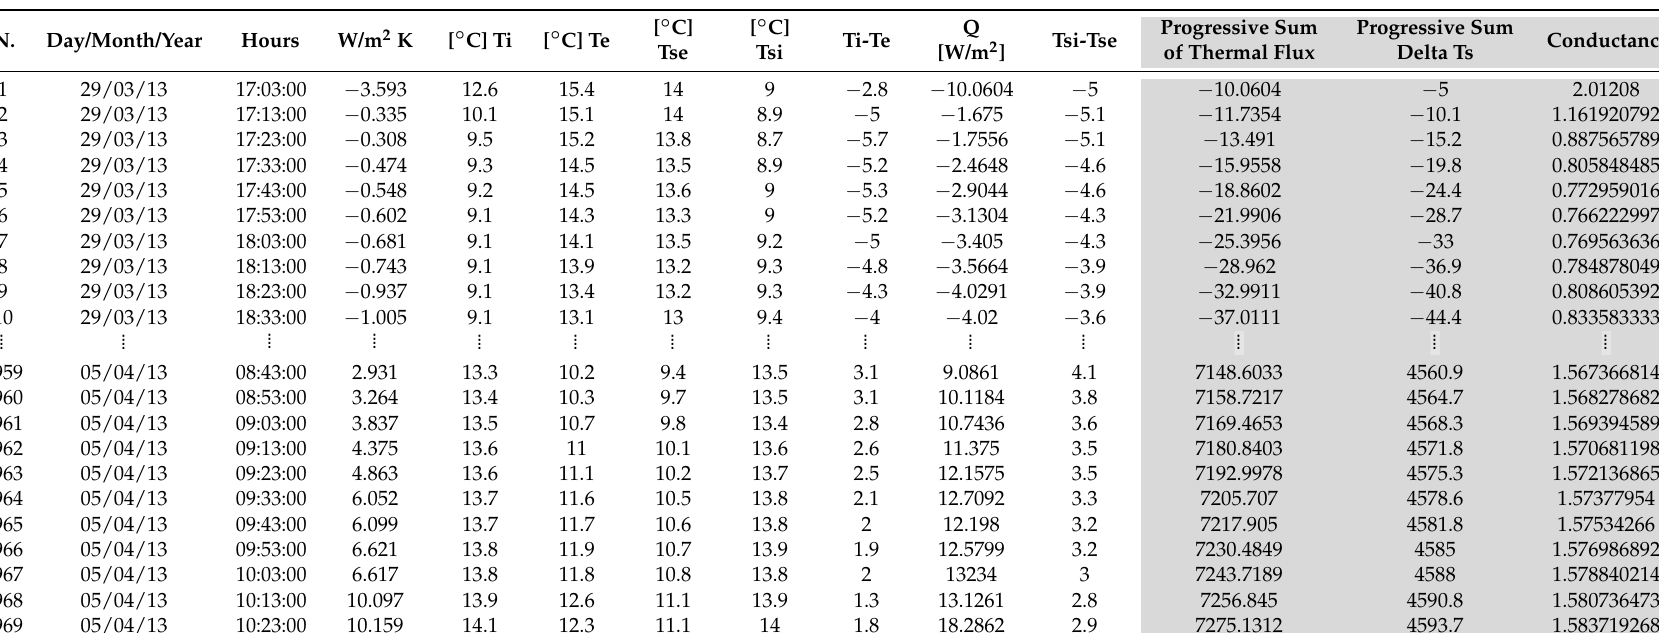
Table 4. On the left side, the data detected by the thermal flux meter. Tabular output. In particular, the data in the table concern the first and the last 10 measurements, so as to highlight the variation of the parameters involved in the measurement. As mentioned, during the day, it was not possible to have a suitable difference of Table 2. On the left side, the data detected by the thermal flux meter Tabular output. In particular, in the table there are data concerning the first and the last 10 Table 2. On the left side, the data detected by the thermal flux meter Tabular output. In particular, in the table there are data concerning the first and the last 10 Table 2. On the left side, the data detected by the thermal flux meter Tabular output. In particular, in the table there are data concerning the first and the last 10 Table 2. On the left side, the data detected by the thermal flux meter Tabular output. In particular, in the table there are data concerning the first and the last 10 Table 2. On the left side, the data detected by the thermal flux meter Tabular output. In particular, in the table there are data concerning the first and the last 10 Table 2. On the left side, the data detected by the thermal flux meter Tabular output. In particular, in the table there are data concerning the first and the last 10 Table 2. On the left side, the data detected by the thermal flux meter Tabular output. In particular, in the table there are data concerning the first and the last 10 Table 2. On the left side, the data detected by the thermal flux meter Tabular output. In particular, in the table there are data concerning the first and the last 10 Table 2. On the left side, the data detected by the thermal flux meter Tabular output. In particular, in the table there are data concerning the first and the last 10 Table 2. On the left side, the data detected by the thermal flux meter Tabular output. In particular, in the table there are data concerning the first and the last 10 Table 2. On the left side, the data detected by the thermal flux meter Tabular output. In particular, in the table there are data concerning the first and the last 10 Table 2. On the left side, the data detected by the thermal flux meter Tabular output. In particular, in the table there are data concerning the first and the last 10 Table 2. On the left side, the data detected by the thermal flux meter Tabular output. In particular, in the table there are data concerning the first and the last 10 Table 2. On the left side, the data detected by the thermal flux meter Tabular output. In particular, in the table there are data concerning the first and the last 10 temperature, so the measurements were not taken into account. On the right side, against the grey background, the calculation of the variables referred to in the measurements, so as to highlight the variation of the parameters involved in the measurement. On the right side, against the grey background, the calculation of the measurements, so as to highlight the variation of the parameters involved in the measurement. On the right side, against the grey background, the calculation of the measurements, so as to highlight the variation of the parameters involved in the measurement. On the right side, against the grey background, the calculation of the measurements, so as to highlight the variation of the parameters involved in the measurement. On the right side, against the grey background, the calculation of the measurements, so as to highlight the variation of the parameters involved in the measurement. On the right side, against the grey background, the calculation of the measurements, so as to highlight the variation of the parameters involved in the measurement. On the right side, against the grey background, the calculation of the measurements, so as to highlight the variation of the parameters involved in the measurement. On the right side, against the grey background, the calculation of the measurements, so as to highlight the variation of the parameters involved in the measurement. On the right side, against the grey background, the calculation of the measurements, so as to highlight the variation of the parameters involved in the measurement. On the right side, against the grey background, the calculation of the measurements, so as to highlight the variation of the parameters involved in the measurement. On the right side, against the grey background, the calculation of the measurements, so as to highlight the variation of the parameters involved in the measurement. On the right side, against the grey background, the calculation of the measurements, so as to highlight the variation of the parameters involved in the measurement. On the right side, against the grey background, the calculation of the measurements, so as to highlight the variation of the parameters involved in the measurement. On the right side, against the grey background, the calculation of the measurements, so as to highlight the variation of the parameters involved in the measurement. On the right side, against the grey background, the calculation of the Equation (1) was inserted. variables of the Equation (1) has been inserted. variables of the Equation (1) has been inserted. variables of the Equation (1) has been inserted. variables of the Equation (1) has been inserted. variables of the Equation (1) has been variables of the Equation (1) has been inserted. variables of the Equation (1) has been inserted. variables of the Equation (1) has been inserted. variables of the Equation (1) has been inserted. variables of the Equation (1) has been inserted. variables of the Equation (1) has been inserted. variables of the Equation (1) has been inserted. variables of the Equation (1) has been inserted. variables of the Equation (1) has been inserted.